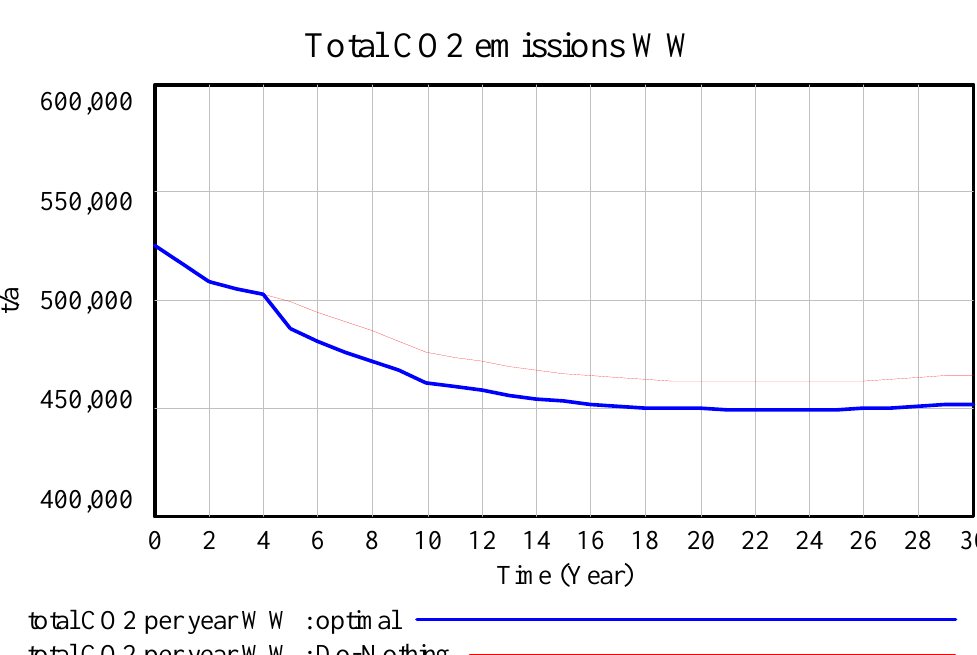
Figure 13. Example outputs from MARS – CO 2 emissions well to